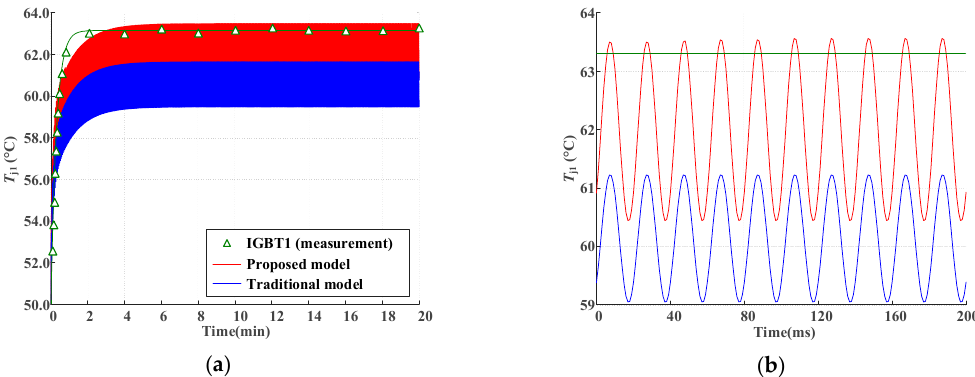
Figure 20. Comparison of junction temperature T j1 of IGBT1 between measurements and model estimation: ( a ) Comparison of temperature curves for 10 minutes; ( b ) model estimation of junction temperature for the last 200 ms.